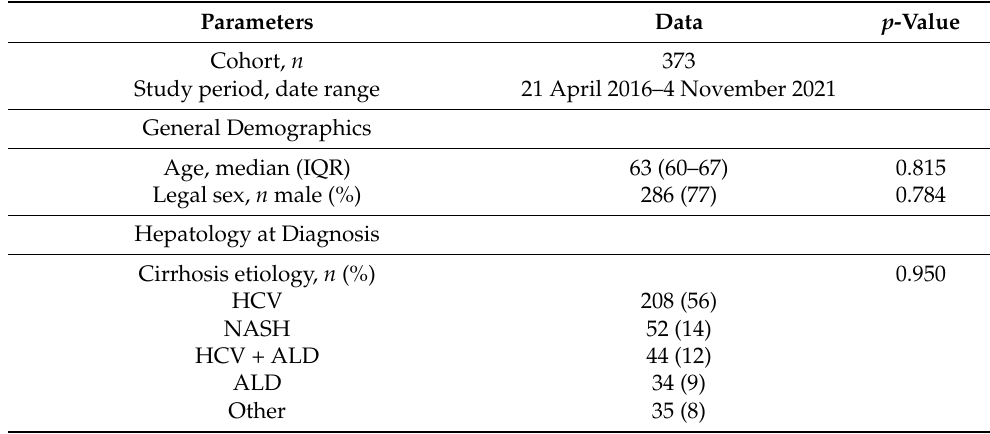
Figure 1. CONSORT Diagram of the Study Cohort. Outline of the study cohort exclusion criteria, analysis cohort characteristics, and subgroup analysis. Abbreviations: hepatocellular carcinoma (HCC), Barcelona Clinic Liver Cancer (BCLC), Eastern Cooperative Oncology Group (ECOG), alpha-fetoprotein (AFP), doxorubicin-eluting embolic transarterially chemoembolization (DEE-TACE), Yttrium-90 (90Y), microwave ablation (MWA). Table 1. Clinical characteristics and time to progression analysis in an intention to bridge to liver transplant